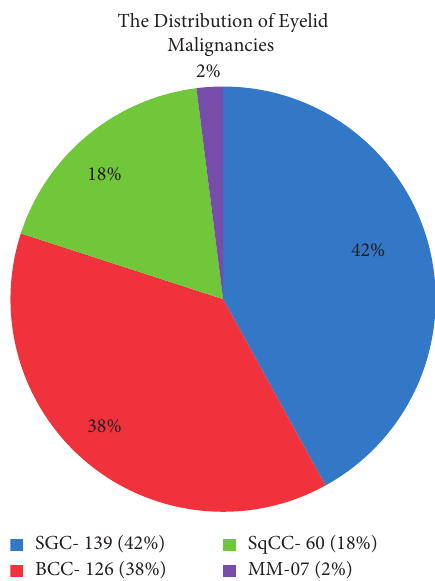
Figure 1: Distribution of eyelid malignant